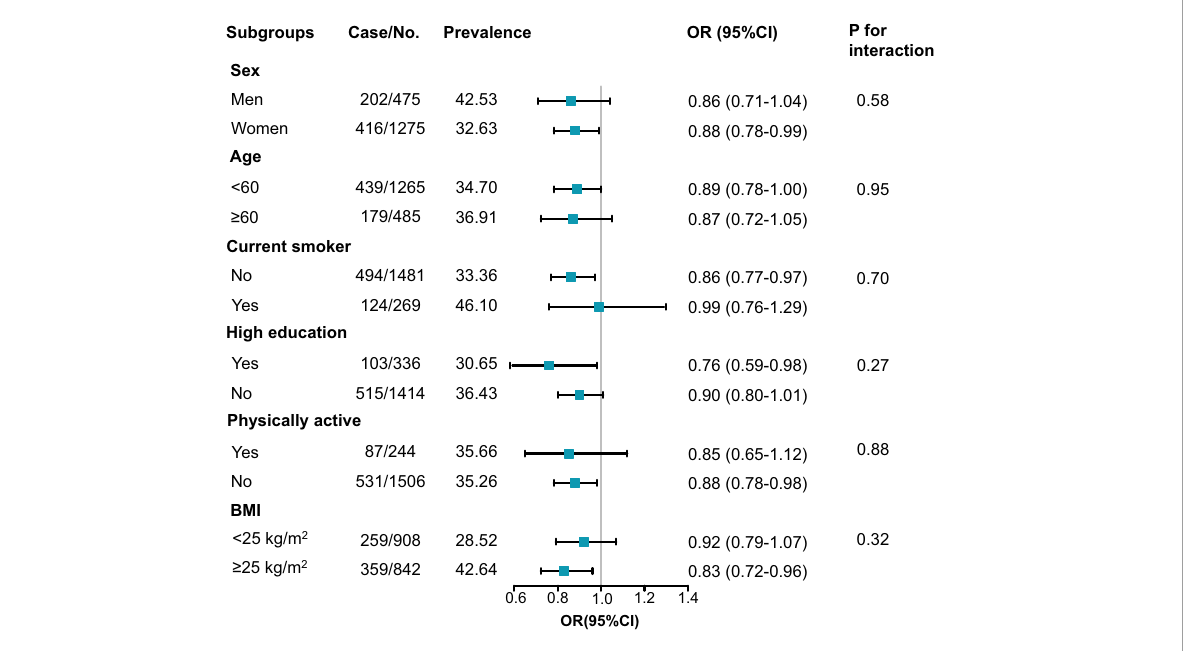
FIGURE 3 Subgroup analysis for the association between serum Sparcl1 per SD increment and prevalence of dyslipidemia. Model was adjusted for age, sex, education of high-school or above, smoking and drinking status, physically active, and BMI (except for the analysis of BMI). BMI, body mass